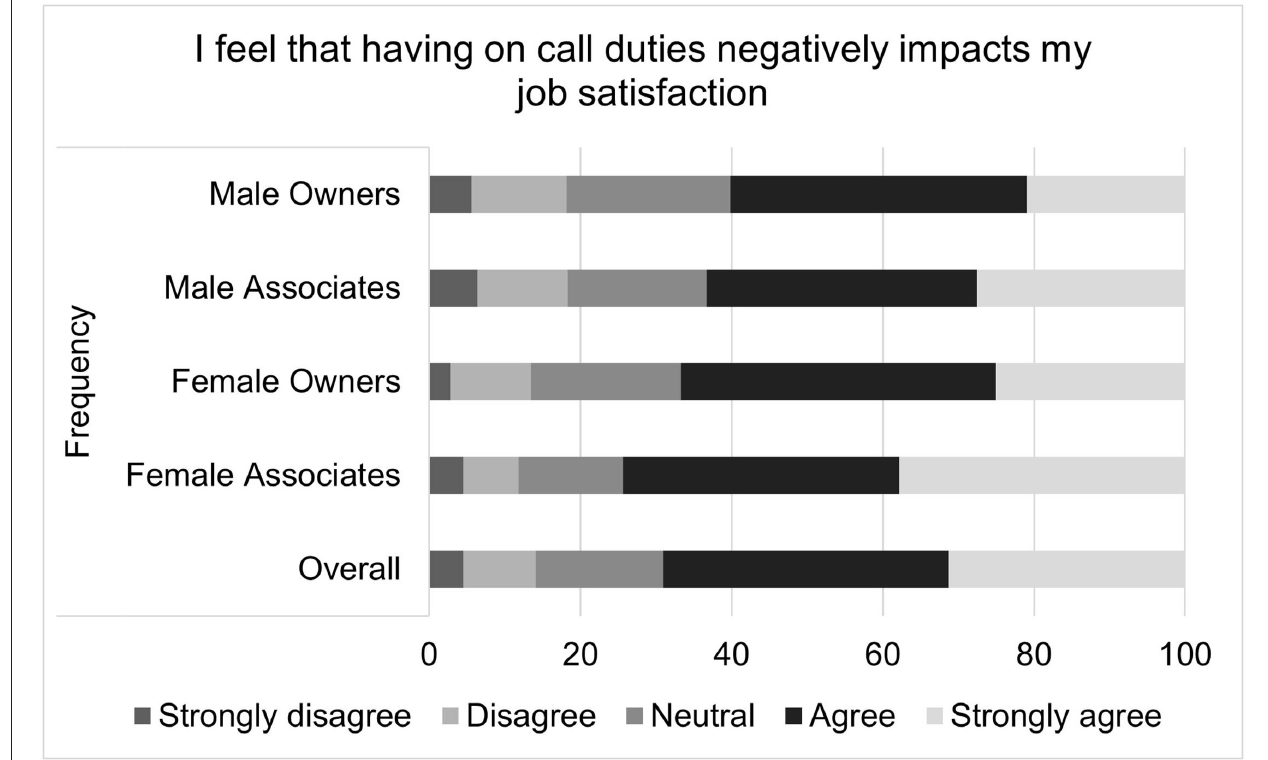
FIGURE 4 | Willingness to leave current job due to on-call responsibilities, as reported by male and female practice owners and associate veterinarians.